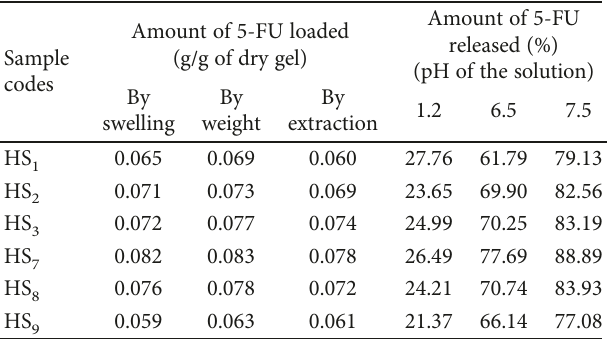
Table 2: Amount of 5-FU loaded and released from selected